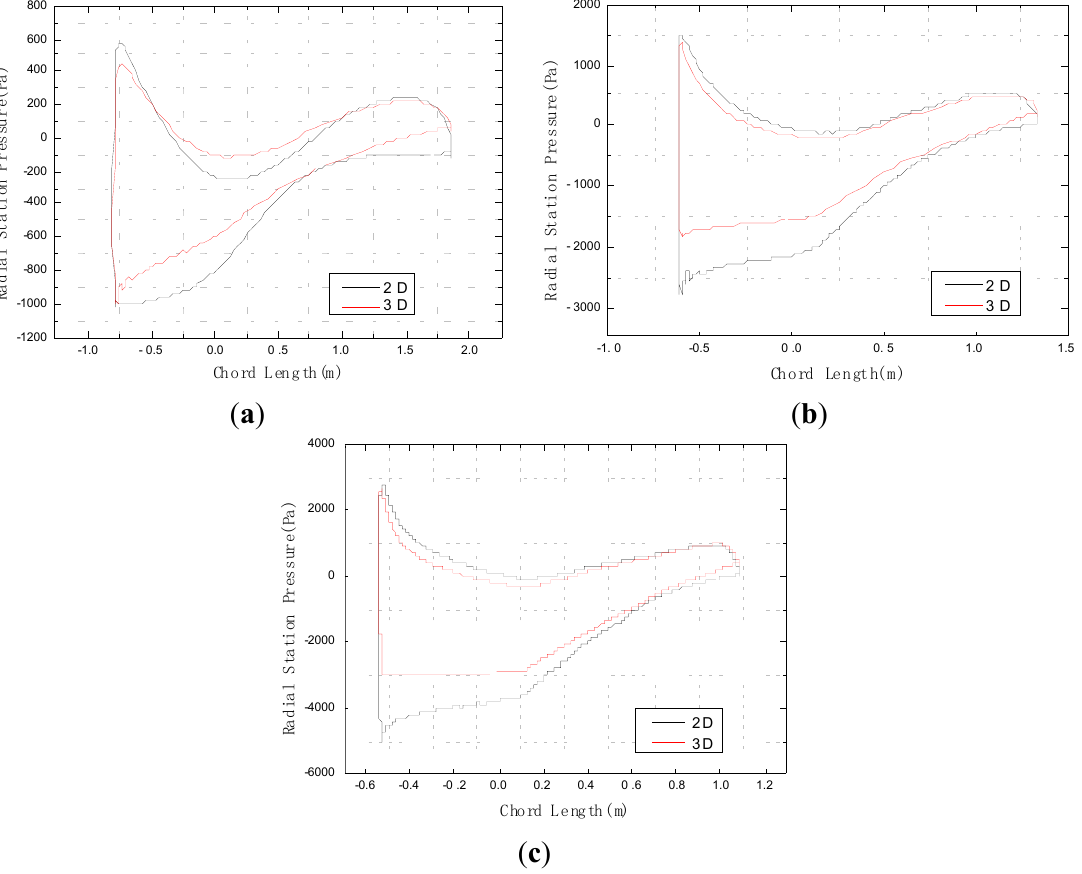
Figure 5. Comparison of pressure computed by 3-D and 2-D CFD. ( a ) r / R = 0.3; ( b ) r / R = 0.6; and ( c ) r / R = 0.85.